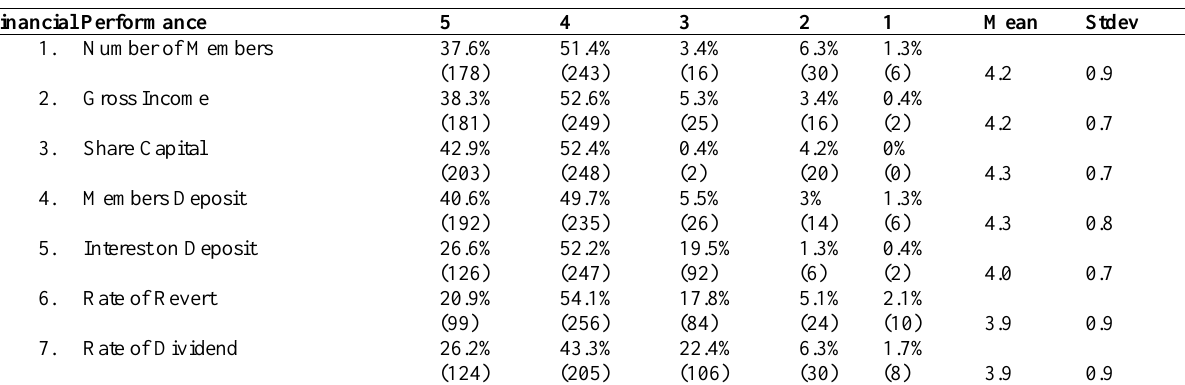
Table 2: Financial